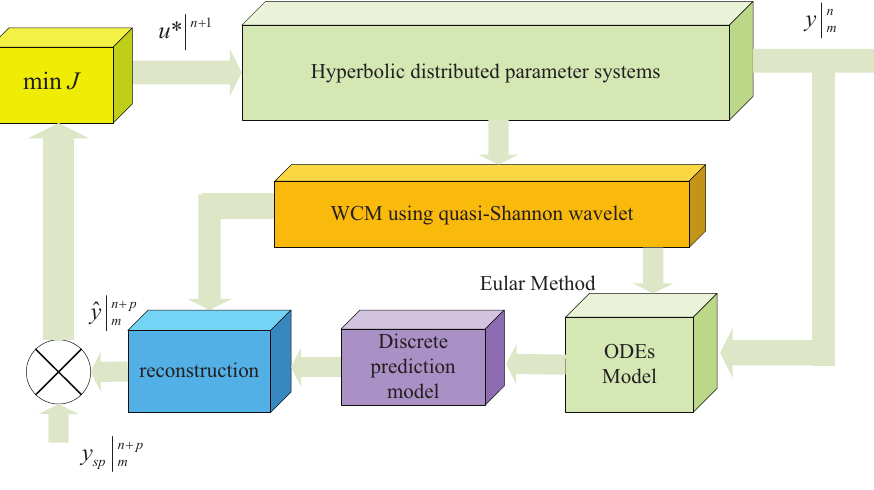
Figure 4. The structure of nonlinear predictive controller using quasi-Shannon wavelet